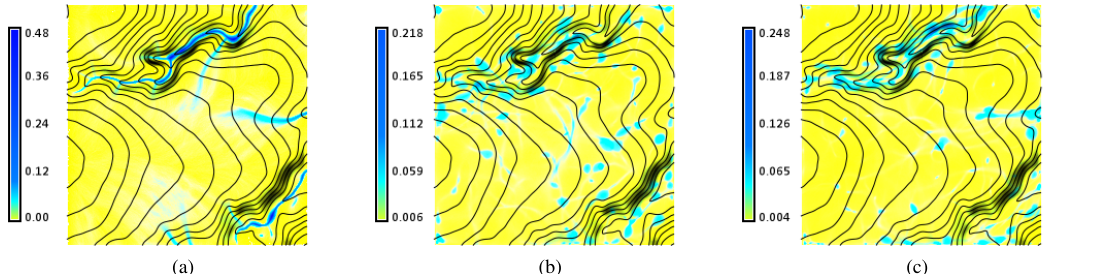
Figure 5: (a) The depth of simulated water flow across the reference landscape, (b) the mean depth using digital modeling, (c) and the